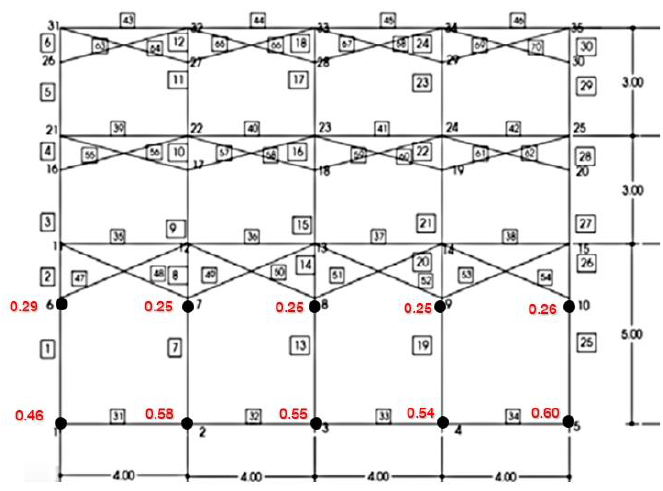
Figure 14. Damage index of the reinforced building structure.